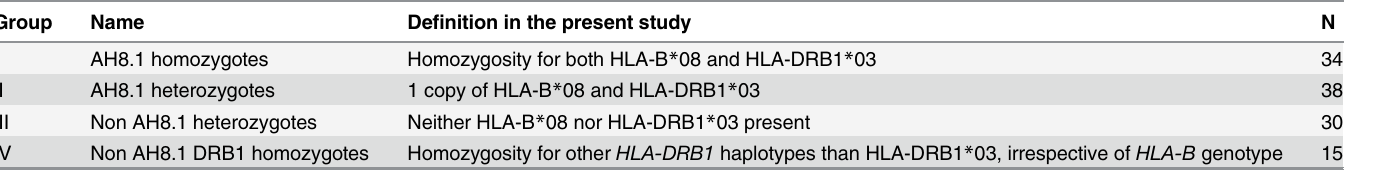
Table 1. Pre-defined HLA genotype